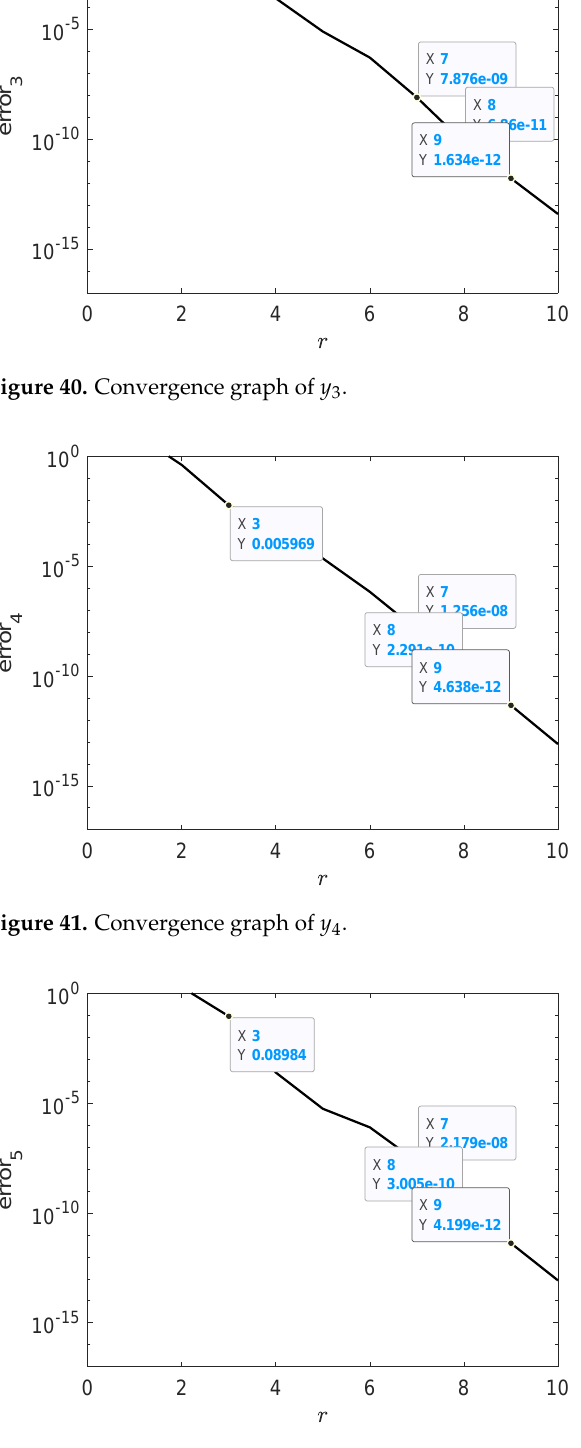
Figure 42. Convergence graph of y 5